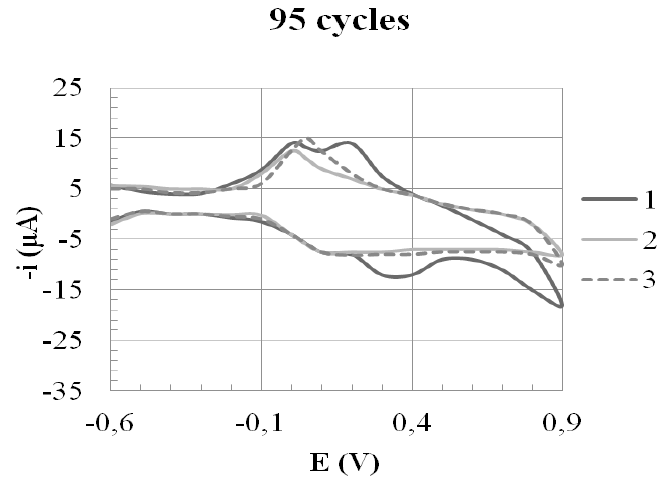
Figure 6. Effect of used electrolyte on the electrochemical behavior of PoAP on a GCE electrode. PoAP film cyclic voltammograms from solutions: (1) 1 mol L -1 HClO , (2) 1 mol L -1 H SO , (3) 1 mol L -1 NH NO +1 mol L -1 NH OH [PoAP film deposited on GCE after polymerization 4 2 4 4 3 4